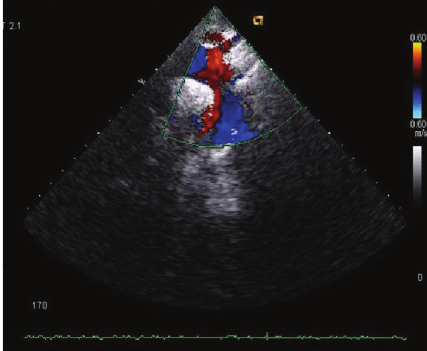
Figure 2: ECHO-Doppler study showing stenosis of the right subclavian artery.